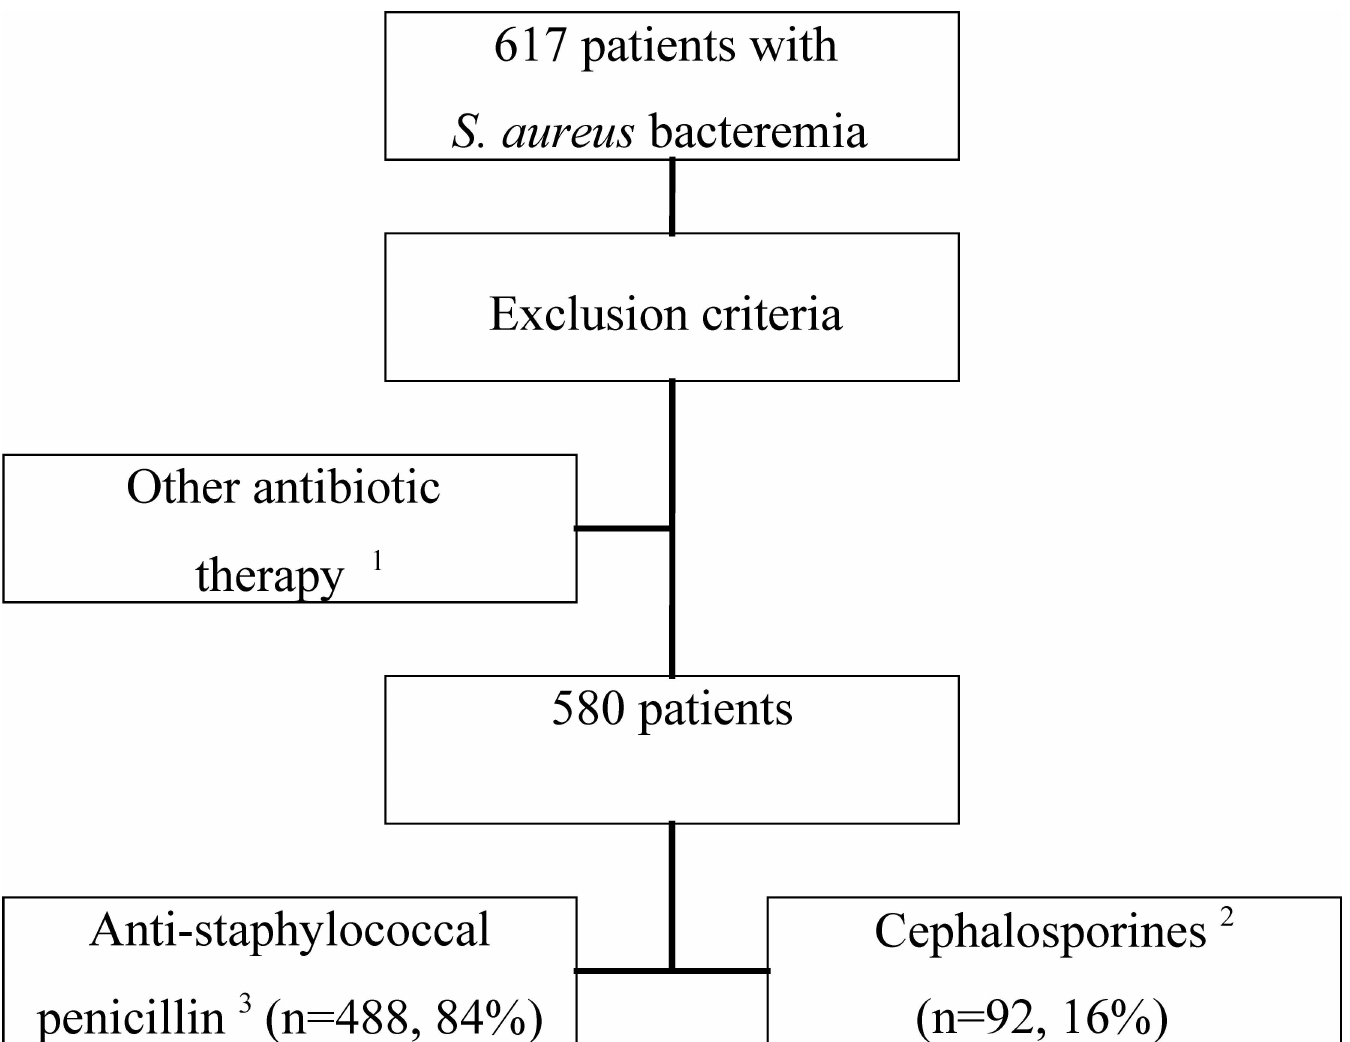
Fig 1. Study profile. Originally 617 patients with methicillin-sensitive Staphylococcus aureus bacteraemia (SAB) were identified.Patients with methicillin- resistant SAB were not includedin the study. Patients were dividedaccordingto anti-staphylococcalpenicillin (cloxacillin)or cephalosporin (cefuroximeor ceftriaxone) therapy duringthe 1 st week. 1 Carbapenemes, Clindamycin, Vancomycin or Piperasillin-Tazobactam 2 Cefuroximeor ceftriaxone 3